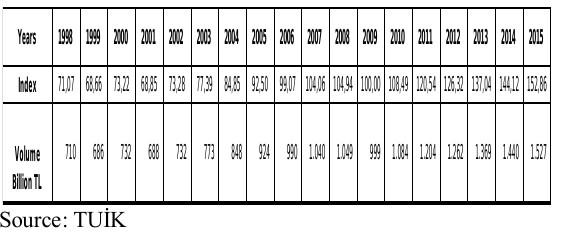
Table 1: GDP (Gross Domestic Product) for 1998- 2015 (TL, bio)